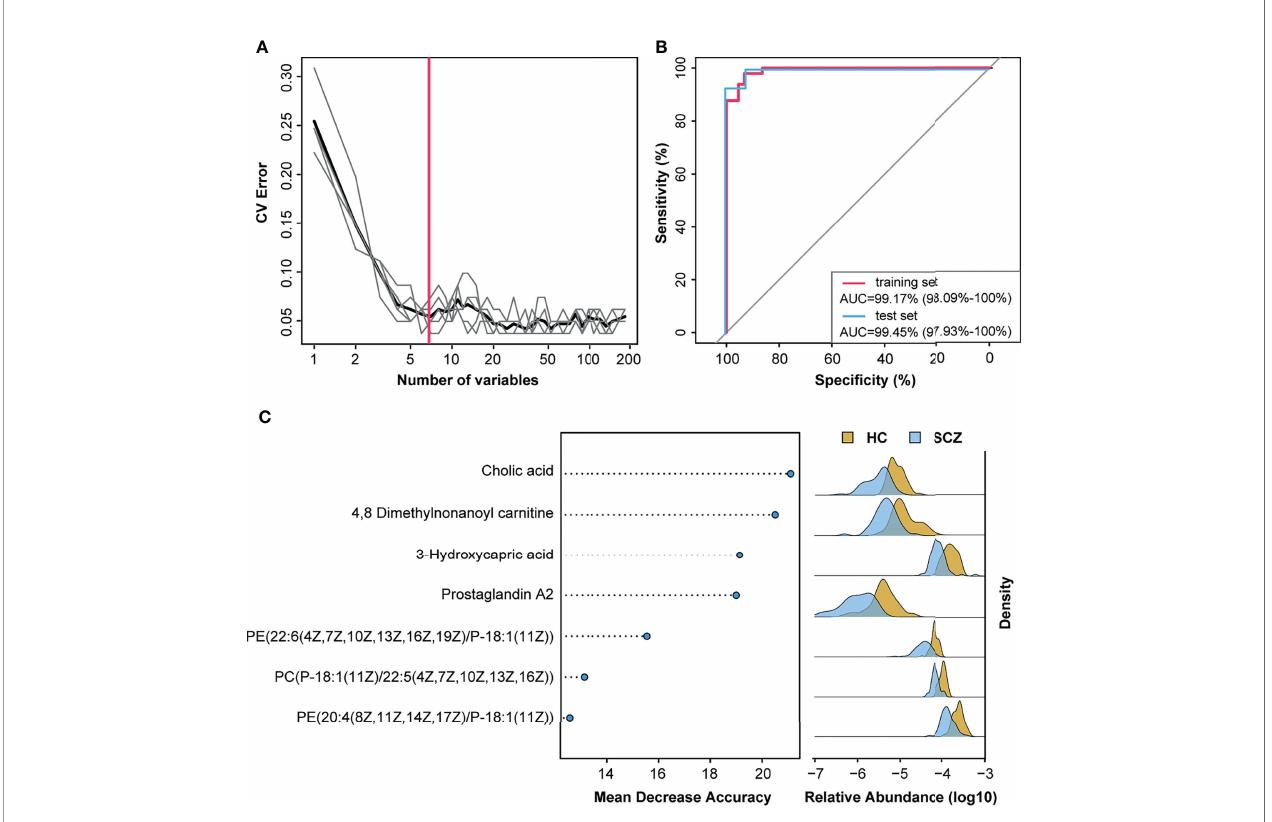
FIGURE 5 | Metabolites classify schizophrenia from healthy control. (A) Distribution of fi ve trials of 10-fold cross-validation error in random forest classi fi cation of schizophrenia as the number of features increases. The model was constructed using relative abundance of the 50 metagenomic operational taxonomic units and 133 metabolites from 70% of schizophrenia and healthy control samples (training set). The black curve indicates the average of the fi ve trials (gray lines). The pink line marks the number of features in the optimal set. (B) Receiver operating characteristic analysis was performed to evaluate the diagnostic performance of these seven metabolite biomarkers, and the areas under the curve of the training set and test set were 99.17% and 99.45%, respectively. (C) The seven metabolites with most weight to discriminate schizophrenia and controls were selected by the cross-validated random forest models. The length of line indicated the importance of the metabolites for classi fi